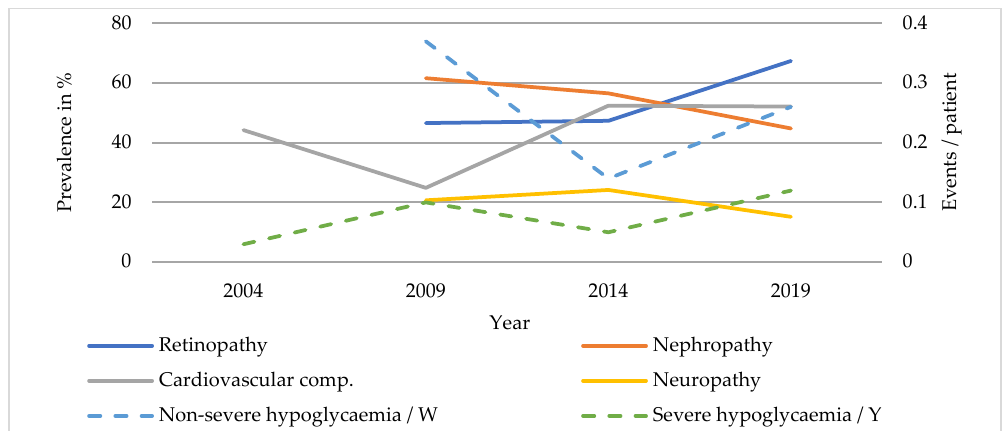
Figure 3. Diabetic complications of patients with T2DM in SC.